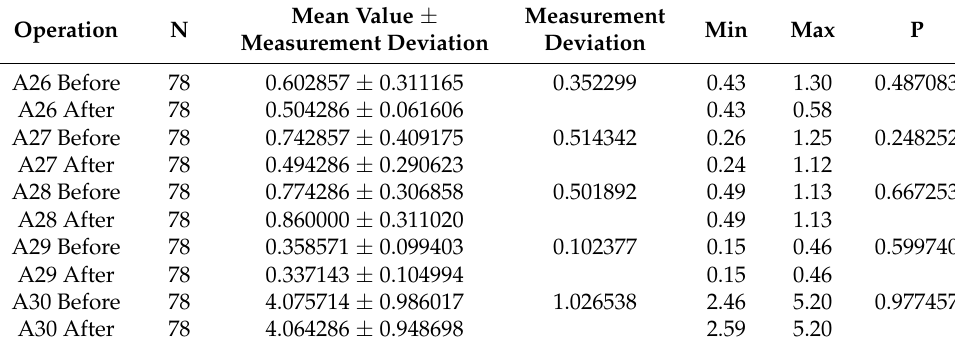
Table 10. Statistical evaluation of measured data